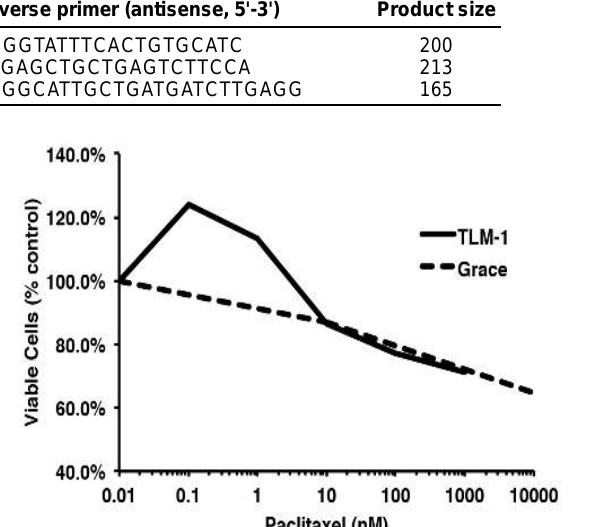
Table 1. Primer Sequences for RT-qPCR Gene